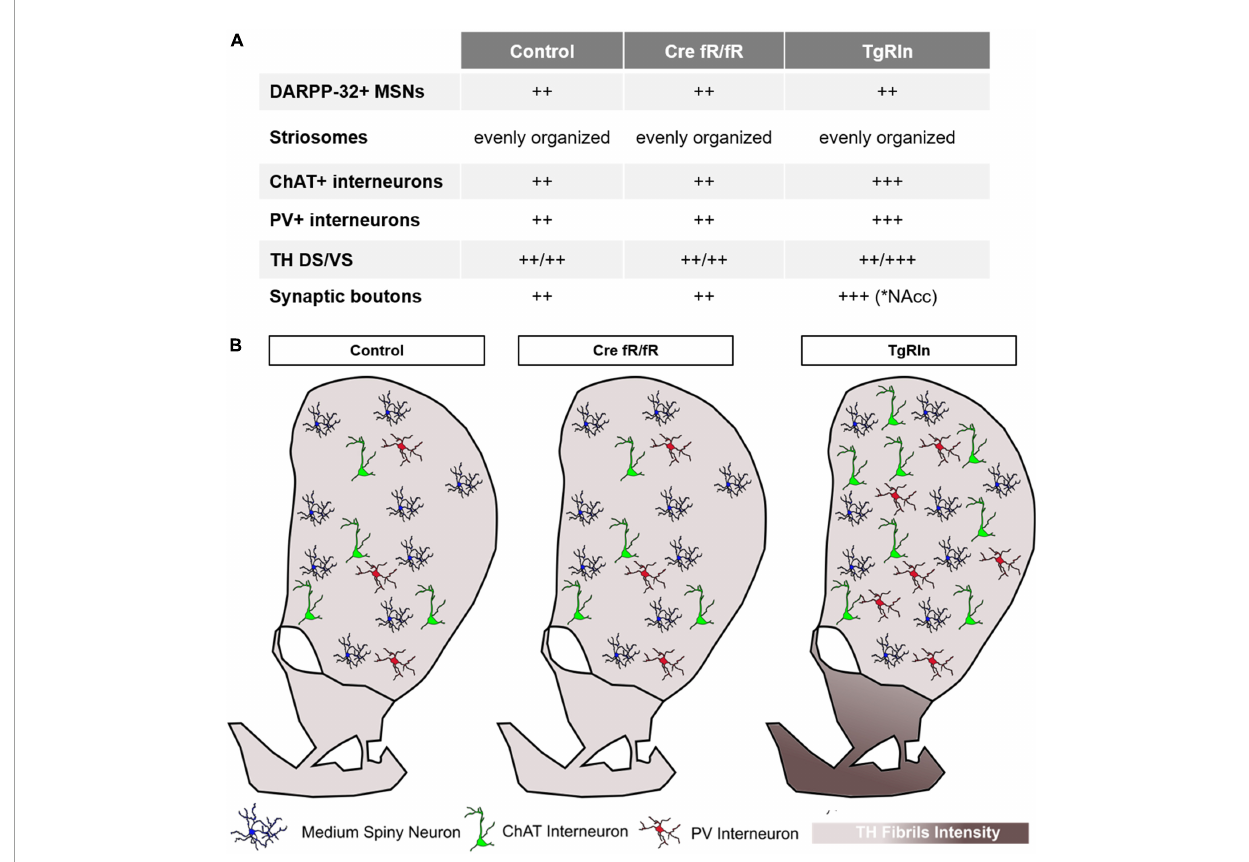
FIGURE7 Schematic summary of the striatal organization in different Reelin mouse models. (A) Summary table indicating the main changes observed in striatal organization in the different strains. (B) Graphic summary of the striatal organization per strain. Density of striatal MSNs is preserved between the control, Cre fR/fR, and TgRln striatums. Although the density of striatal PV+ and ChAT+ interneurons is maintained between control and Cre fR/fR mice, it is increased in the DS of TgRln mice. Increased numbers of ChAT+ interneurons are present in the dorsal striatum and higher numbers of PV+ interneurons are distributed in the ventral medial striatum sub-region. Dopaminergic projections are represented with different gradient of brown color, showing a specific increase of TH fibers in the NAcc and OT of the TgRln mice compared with